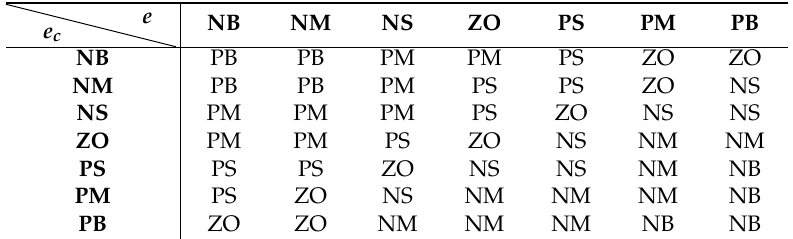
Table A1. Fuzzy rule list of K (cid:48) p .